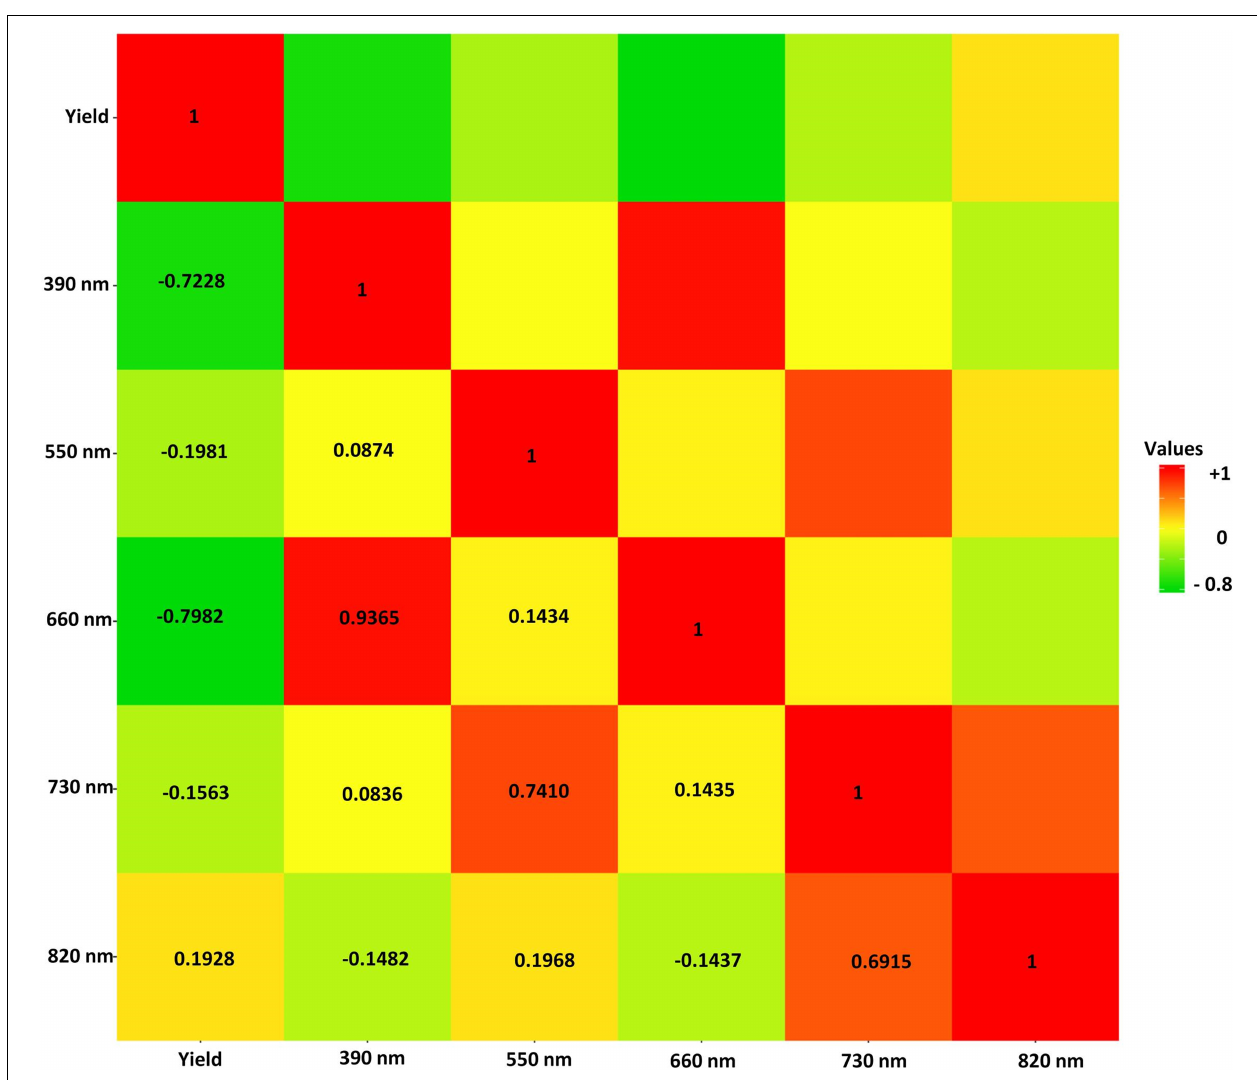
FIGURE 6 | The Pearson correlation of the selected hyperspectral reflectance bands in the tested soybean panel. The heat map scale for values is provided by color for the panel.